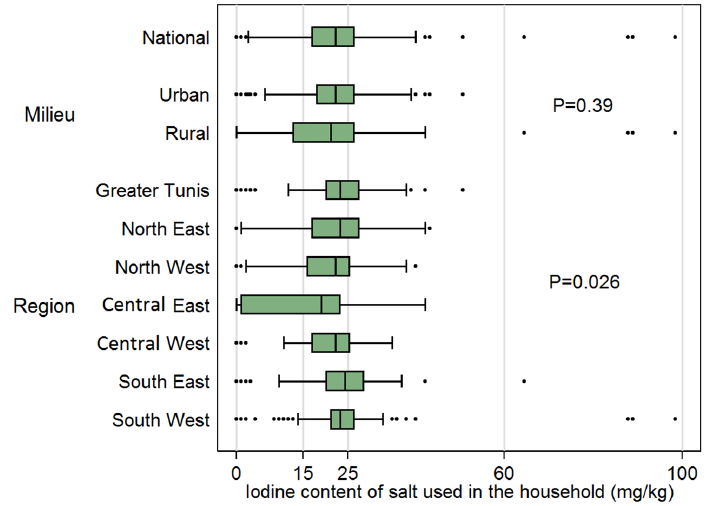
Figure 1. Iodine content of salt used in the households of Tunisian children aged 6–12 years. P ‐ values: design based chi ‐ square test for salt iodine content in quintiles (as figured by vertical reference lines) × factor variable.